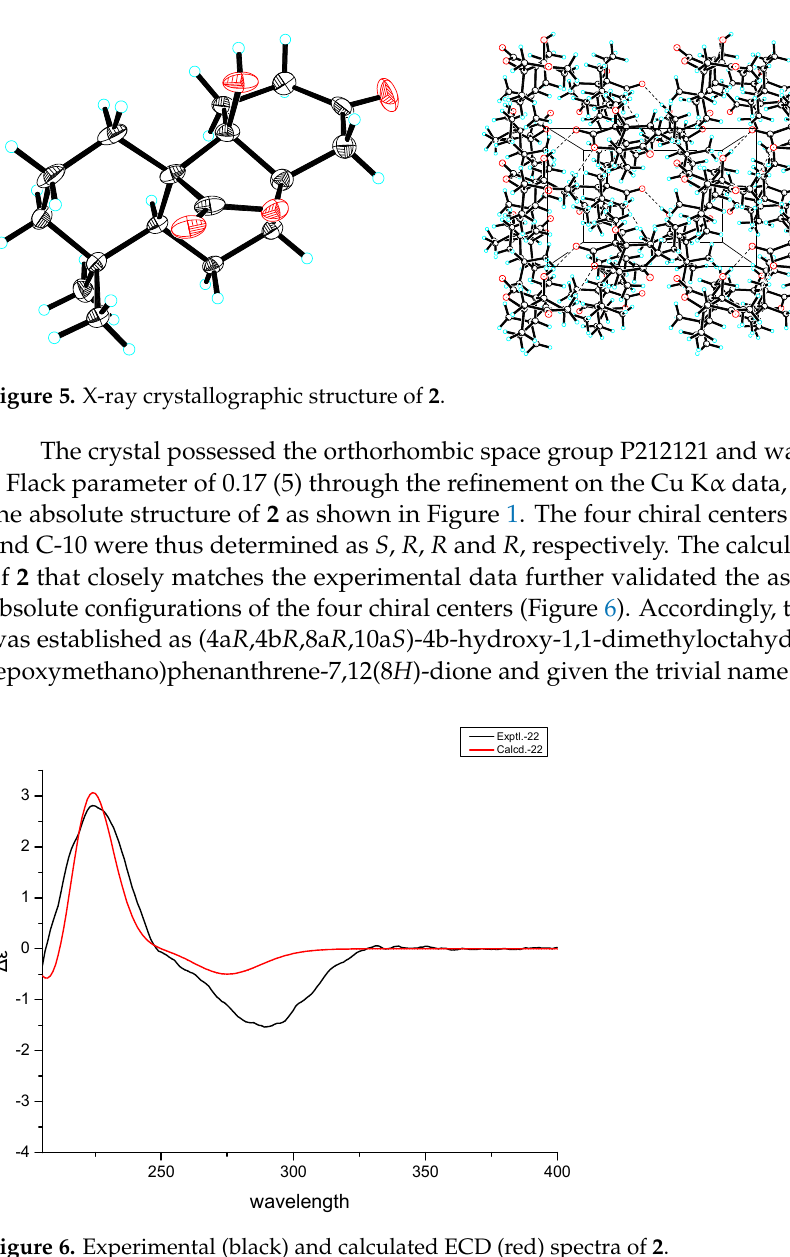
Figure 6. Experimental (black) and calculated ECD (red) spectra of 2.